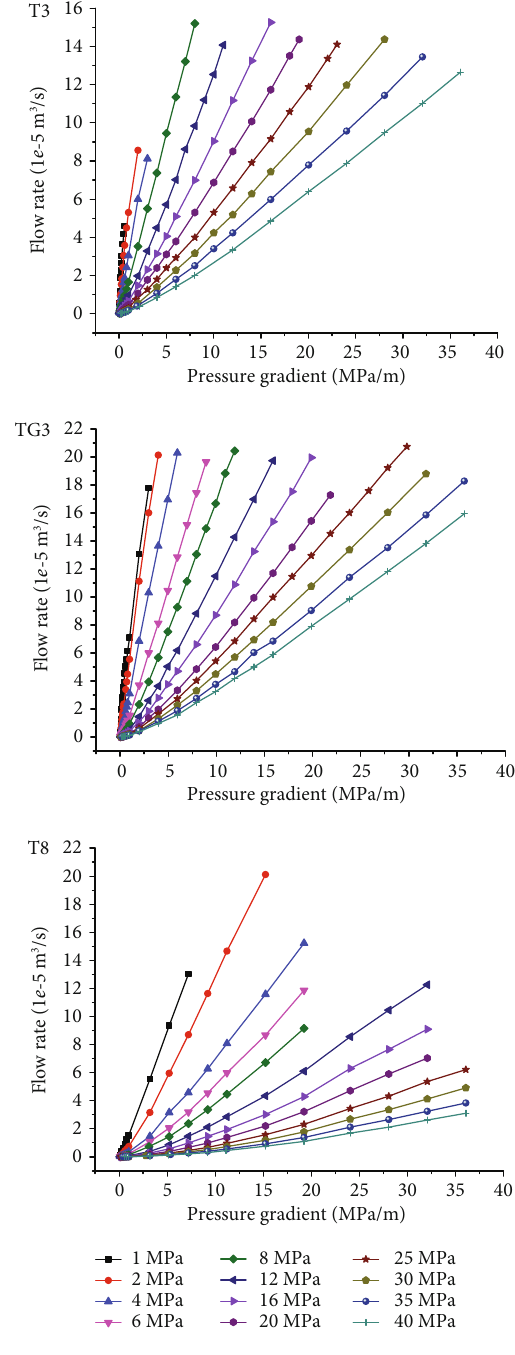
Figure 6: Outlet fl ow rate as a function of the pressure